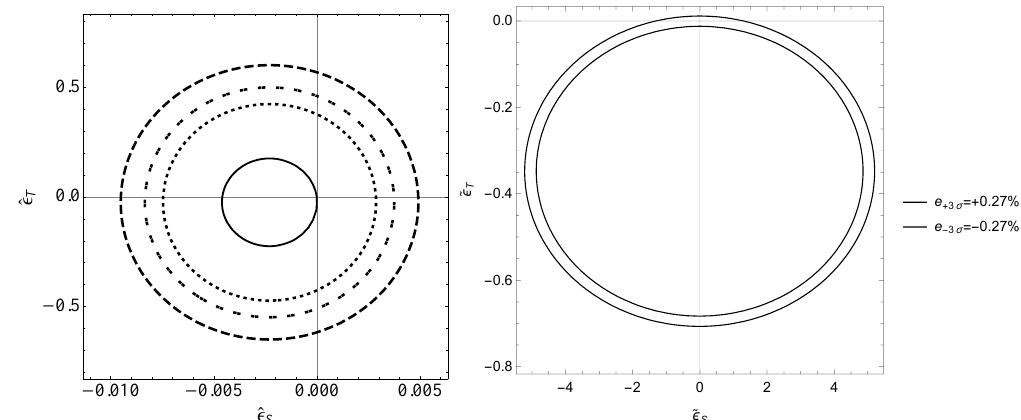
ε ε ) [ 3 ] from current upper limits on , (cid:98) (cid:98) S T ε ε ) from measurements of B ( τ − → π − π 0 ν , (cid:98) (cid:98) S T